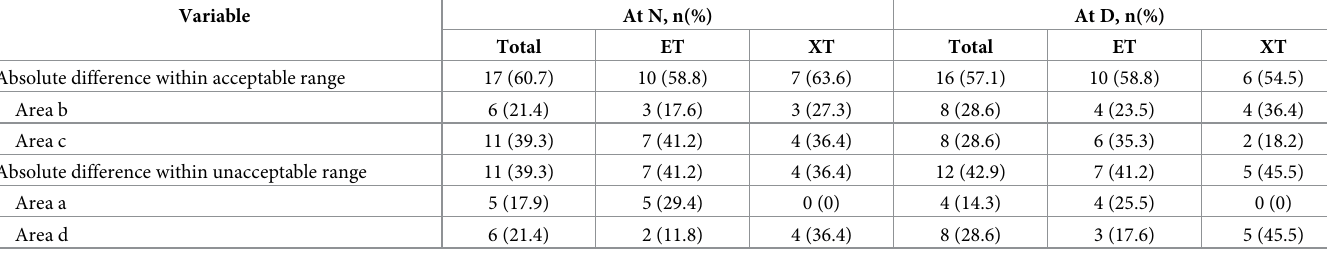
Table 1. Summary results of correlation between angle of deviation from the Photo-Hirschberg test with the APCT.